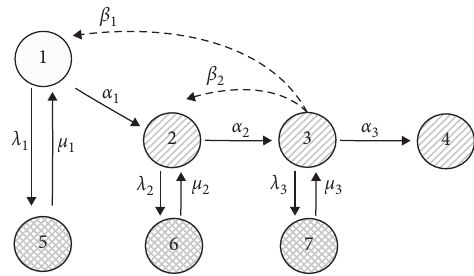
Figure 7: State transition diagram of the example with PM. Table 2: Performance distribution of